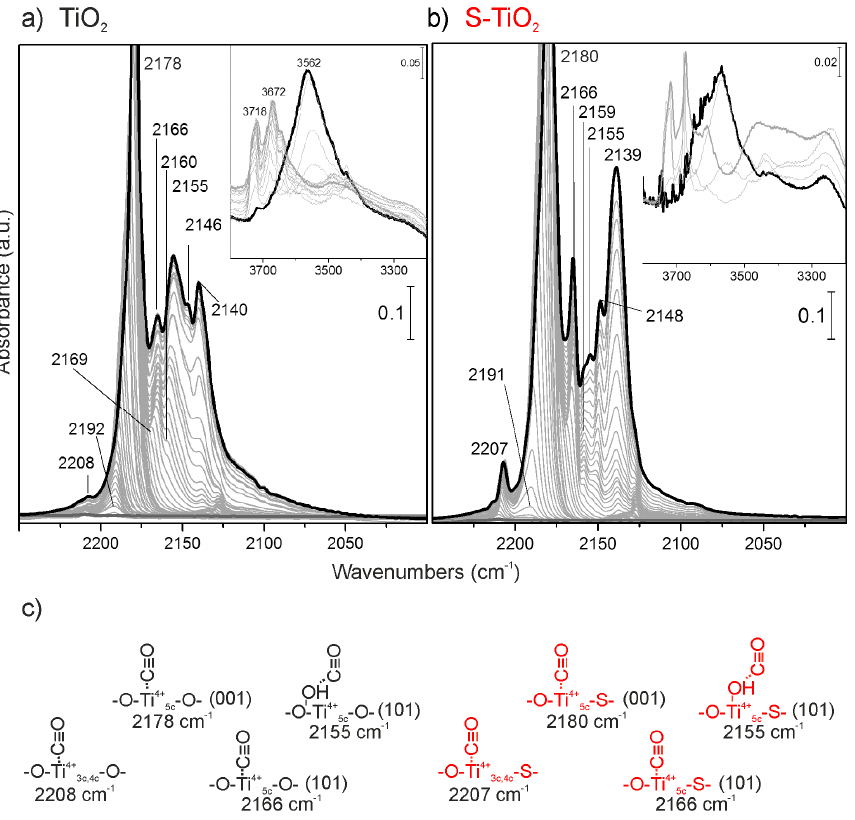
Figure 4. FTIR spectra of CO adsorbed at 100 K on ( a ) TiO 2 and ( b ) S-doped TiO 2 at decreasing coverages (black bold line, maximum coverage: p CO = 70 Torr, grey bold line, minimum coverage: p CO → 0); ( c ) scheme modelling of Ti sites on two different faces interacting with CO molecules and the frequency values of the corresponding bands at maximum coverage (black bold